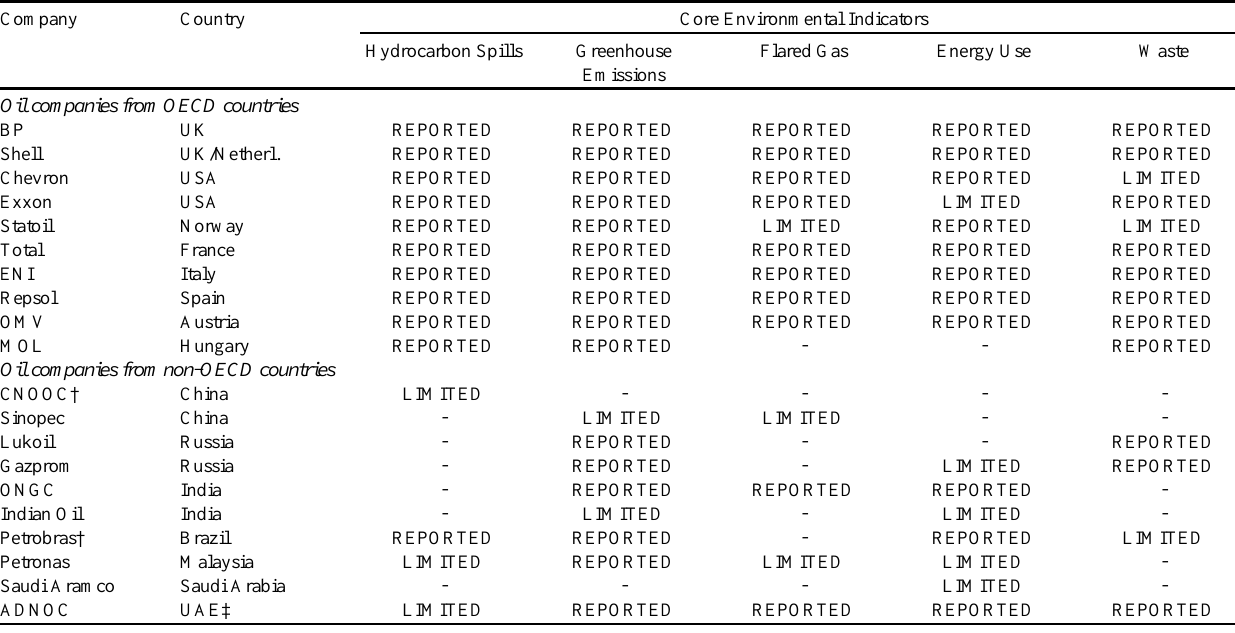
Table 2 . Core environmental indicators reported by selected oil companies for 2010.